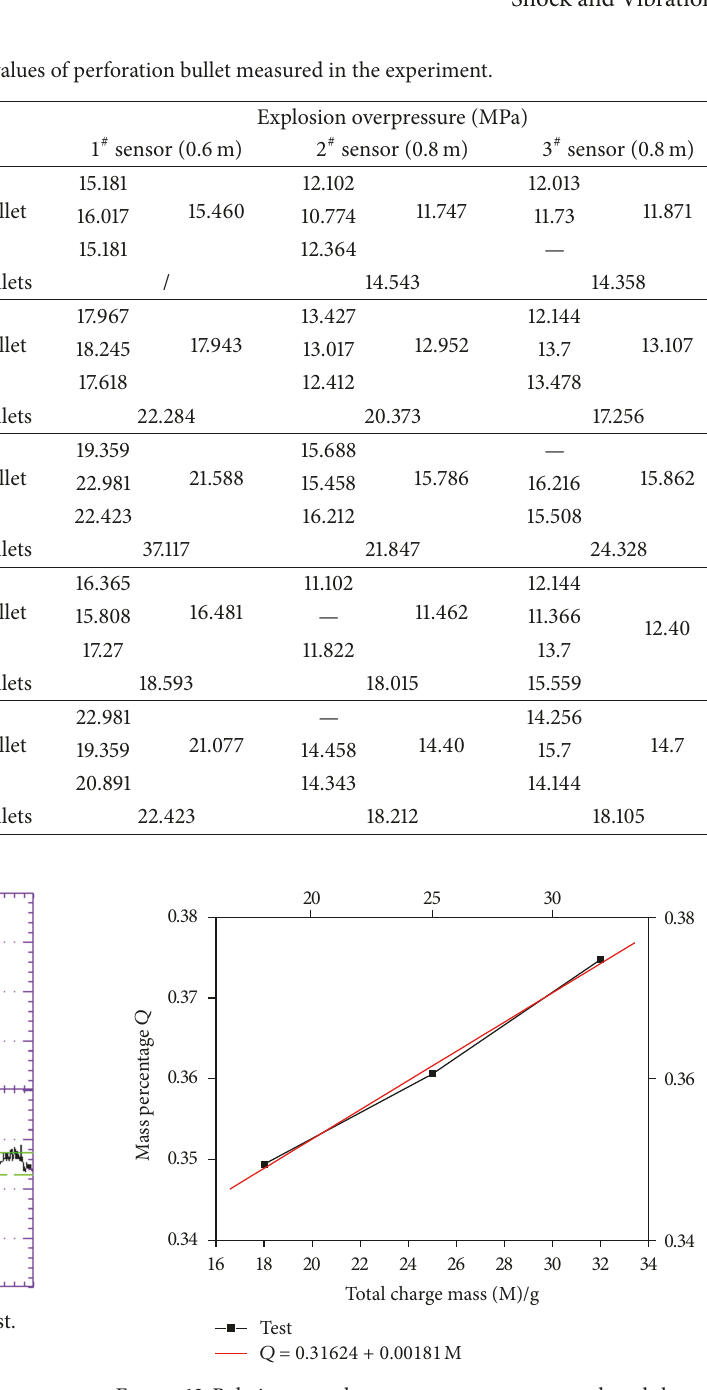
According to the different types of perforating